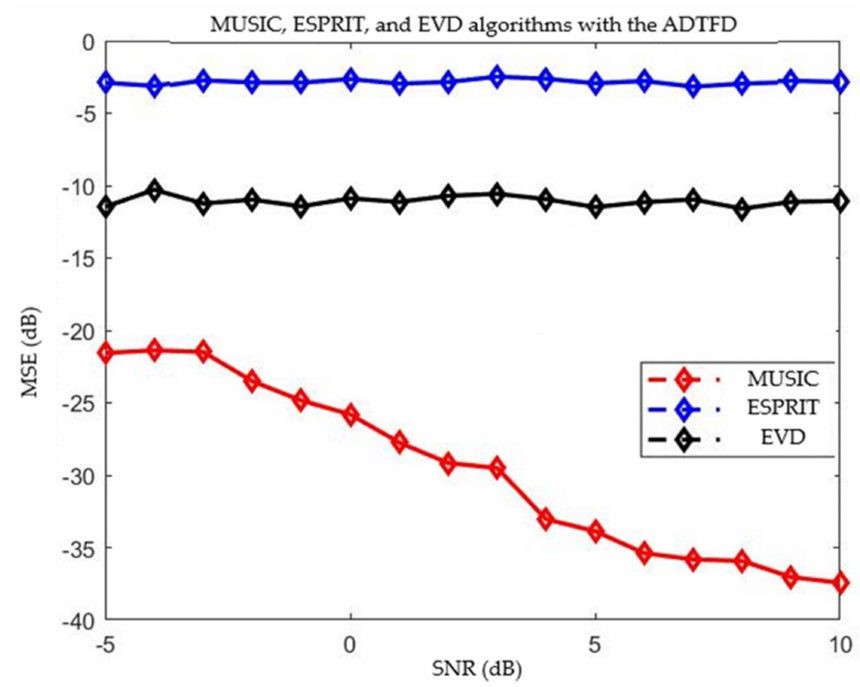
Figure 6. SNR vs. MSE plot of the MUSIC, ESPRIT, and EVD algorithms using the ADTFD.